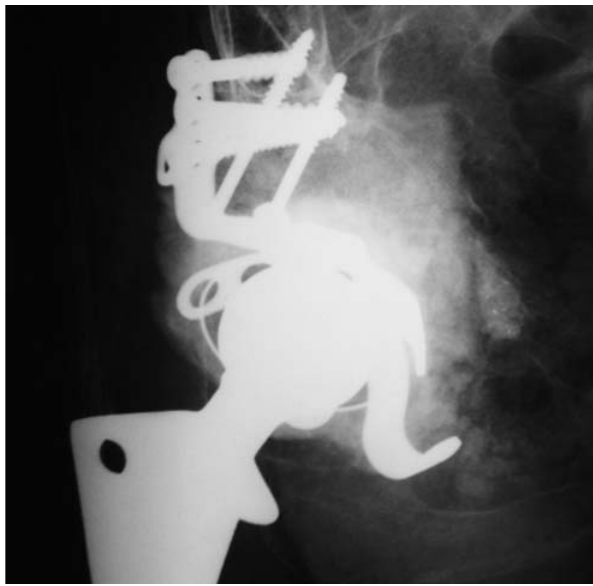
Figure 3 - Immediate post-operative radiography showing the acetabular reconstruction with lyophilized bovine graft and reinforcement device